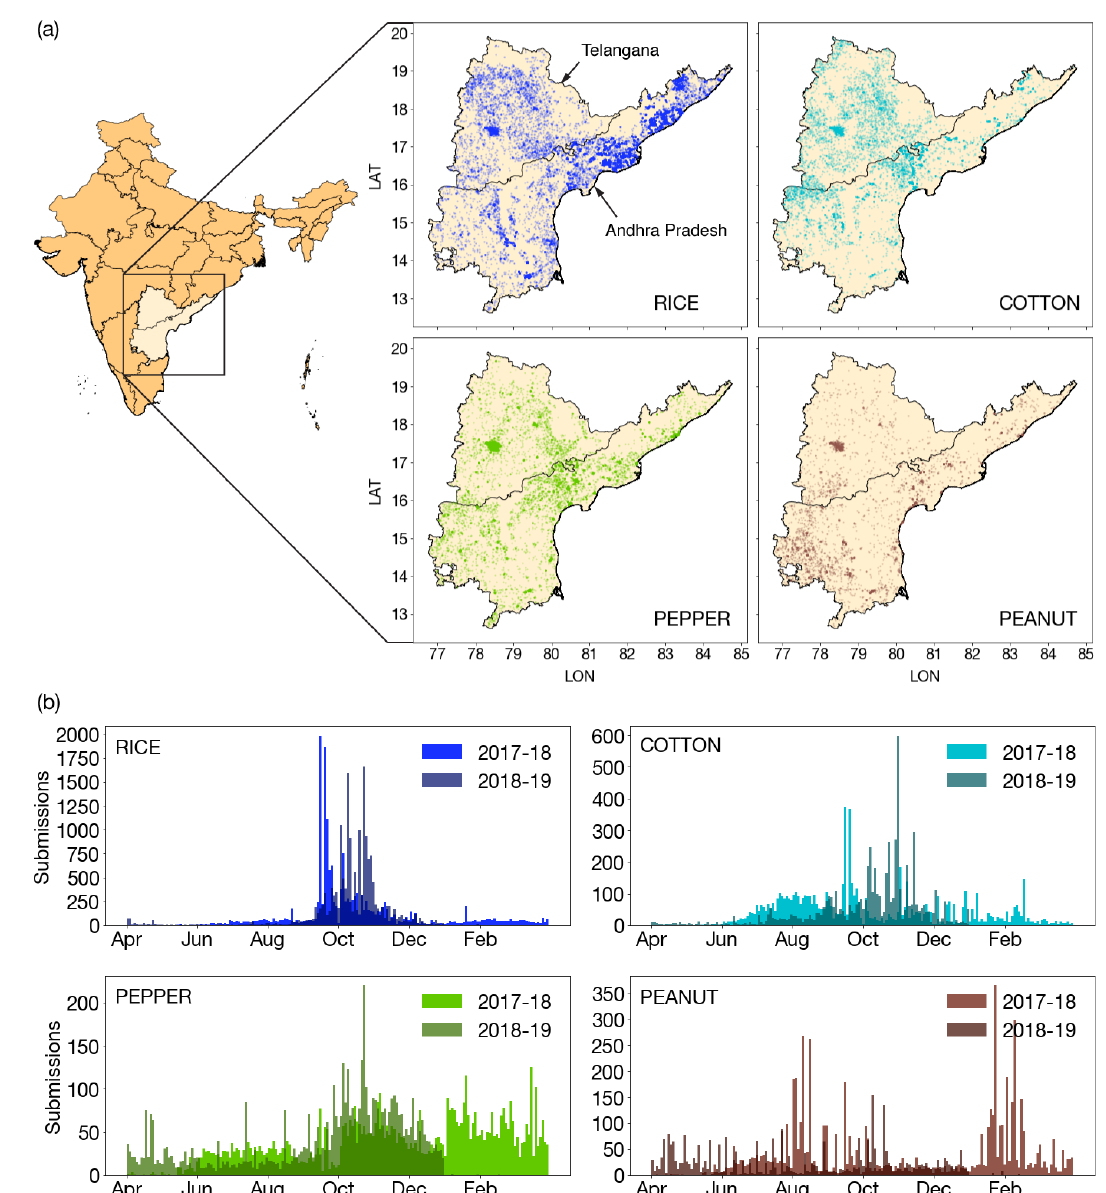
Figure 1. Map and submission times of Plantix dataset. ( a ) Geographic distribution of farmer submissions for rice, cotton, pepper, and peanut. These four crops have the most Plantix submissions within the states of Andhra Pradesh and Telangana (for maps of all ten crop types, see Figure A1). ( b ) Farmer submissions per day from 1 April 2017 to 31 December 2019 for the same four